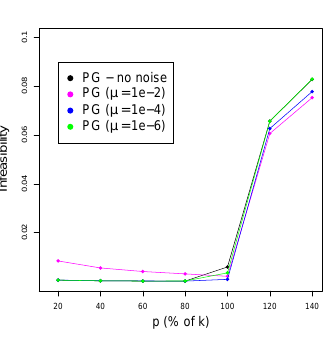
Values of infeas G , H achieved by Algorithm 2 for n = 200, on the original and on the noisy BION data.